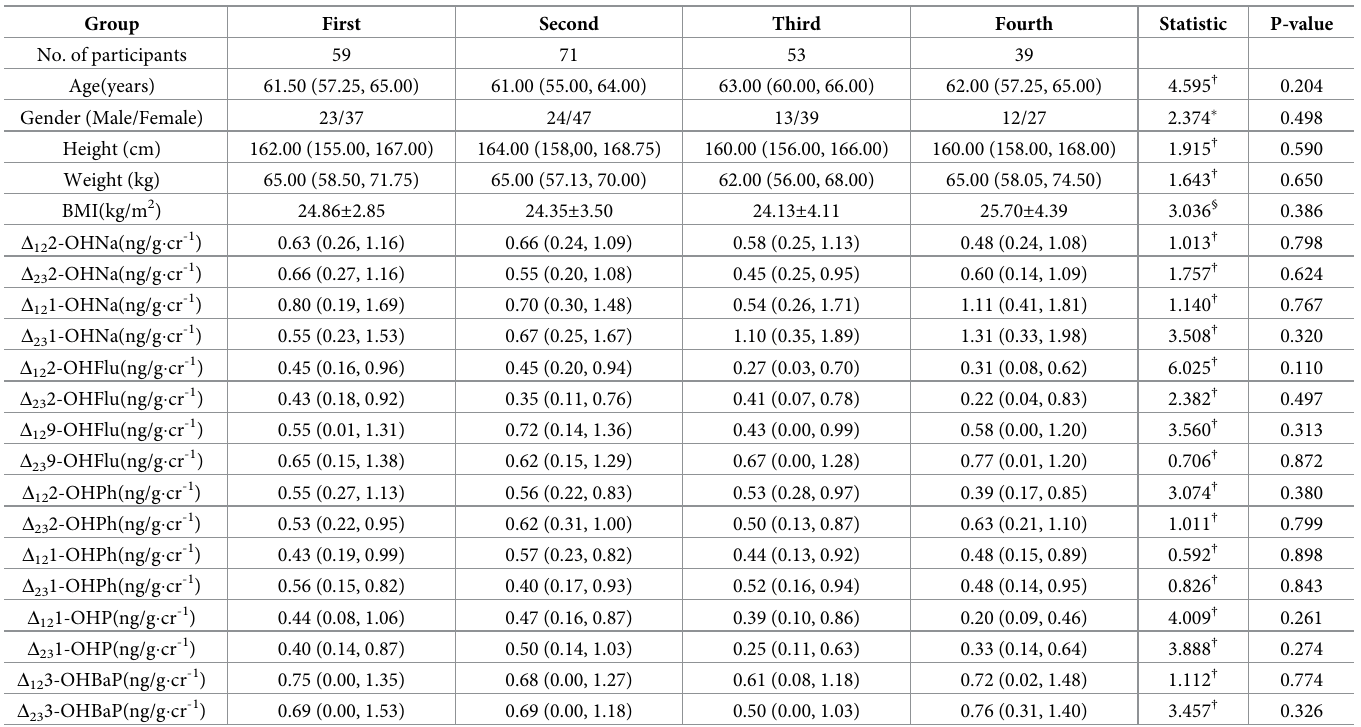
Table 1. Basic information of 222